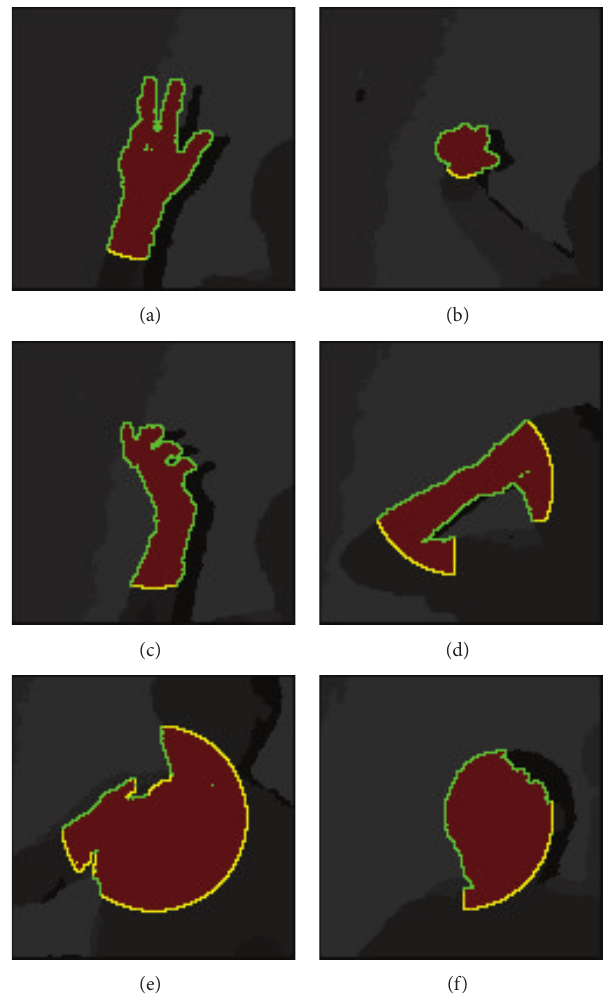
Figure 11: Results of region growing and boundary